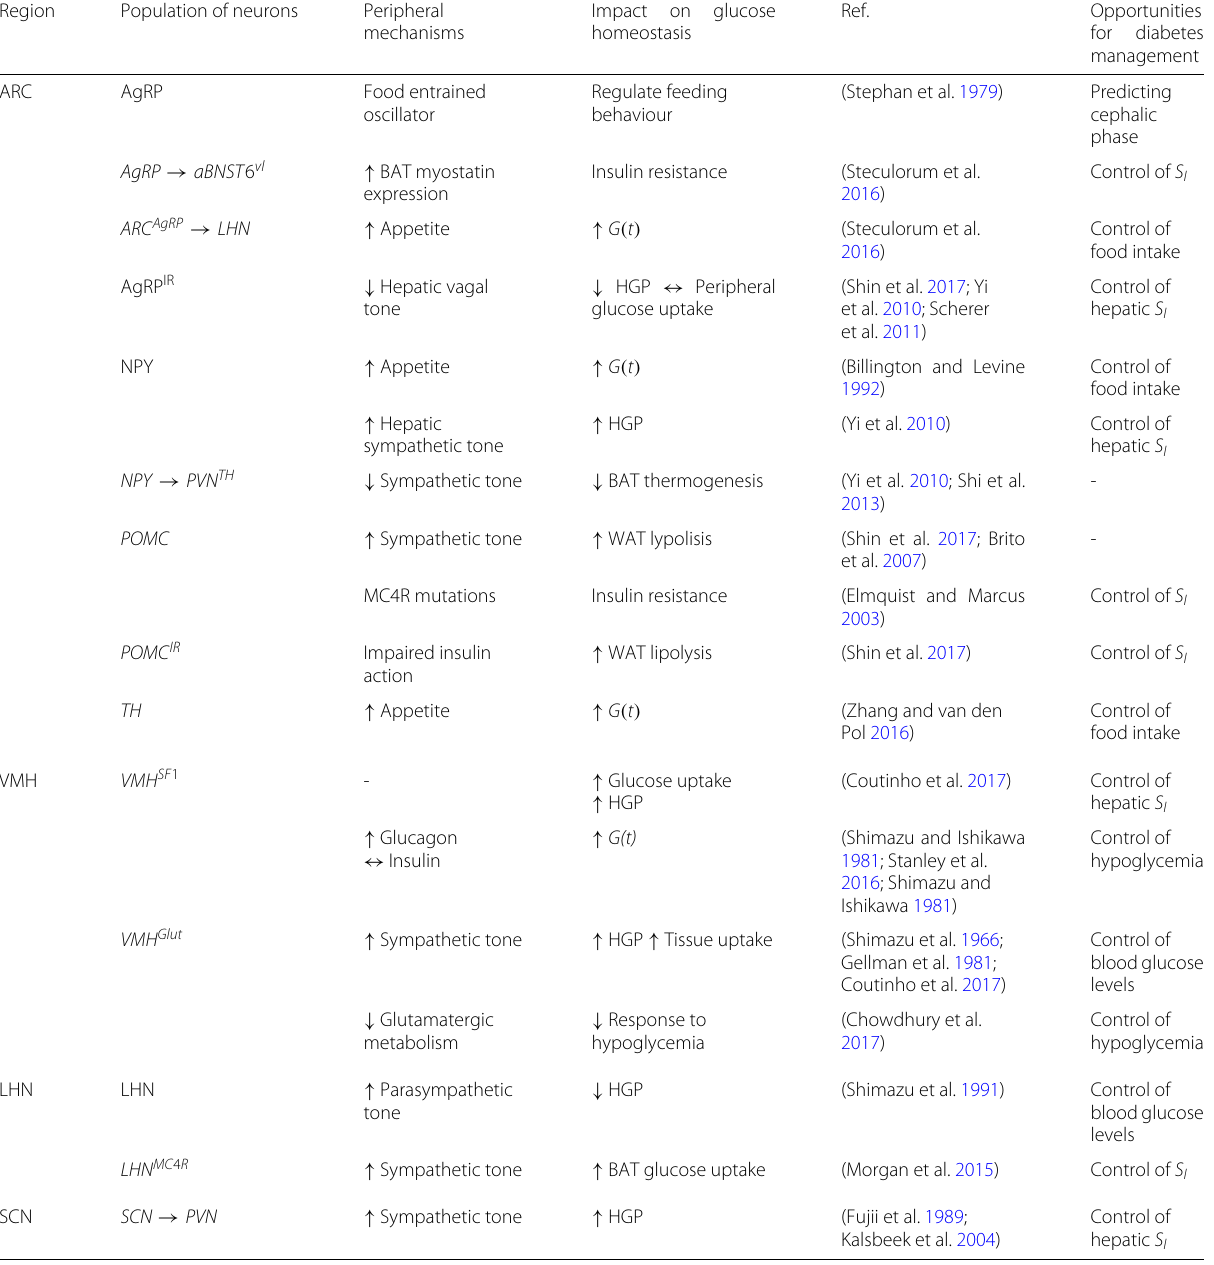
Table 1 Central mechanisms involved in glucose homeostasis and benefit of modulating them for diabetes management